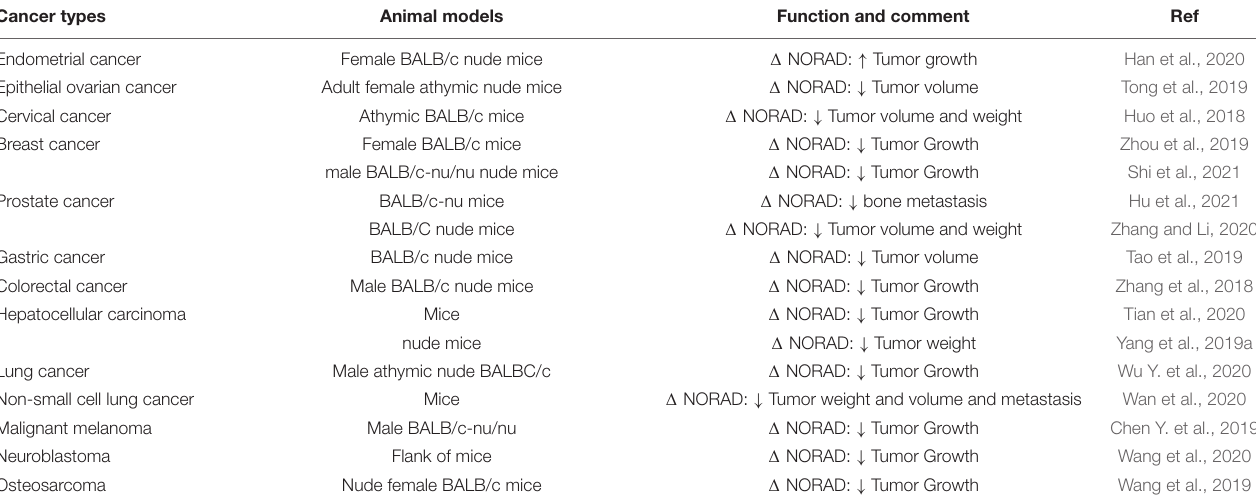
TABLE 3 | Outline of studies which assessed function of NORAD in animal models ( (cid:49) : knock down or